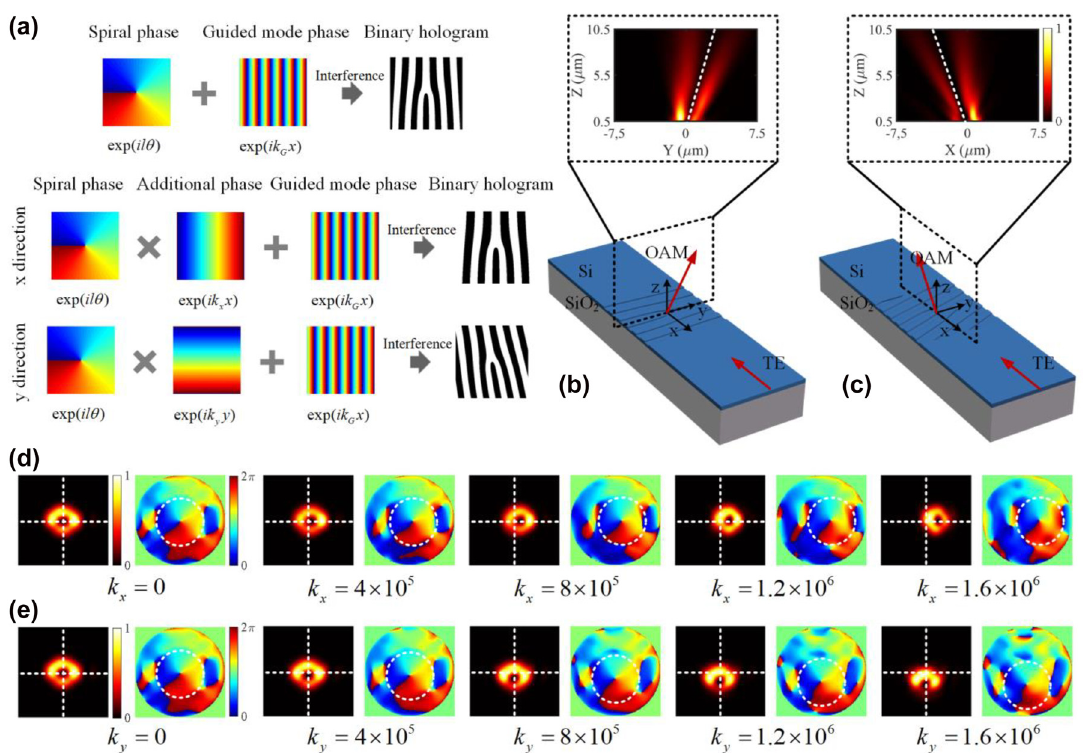
Figure 5: The principle and simulation results of the proposed vortex beam generator for directed emission. (a) The design principle of the subwavelength holographic fork grating. (b, c) the schematic diagram of angled emitting in the x and y directions, respectively. (d, e) The simulated normalized intensity and phase distribution of the angle emitting vortex beams with respect to the additional phase and k , k x y